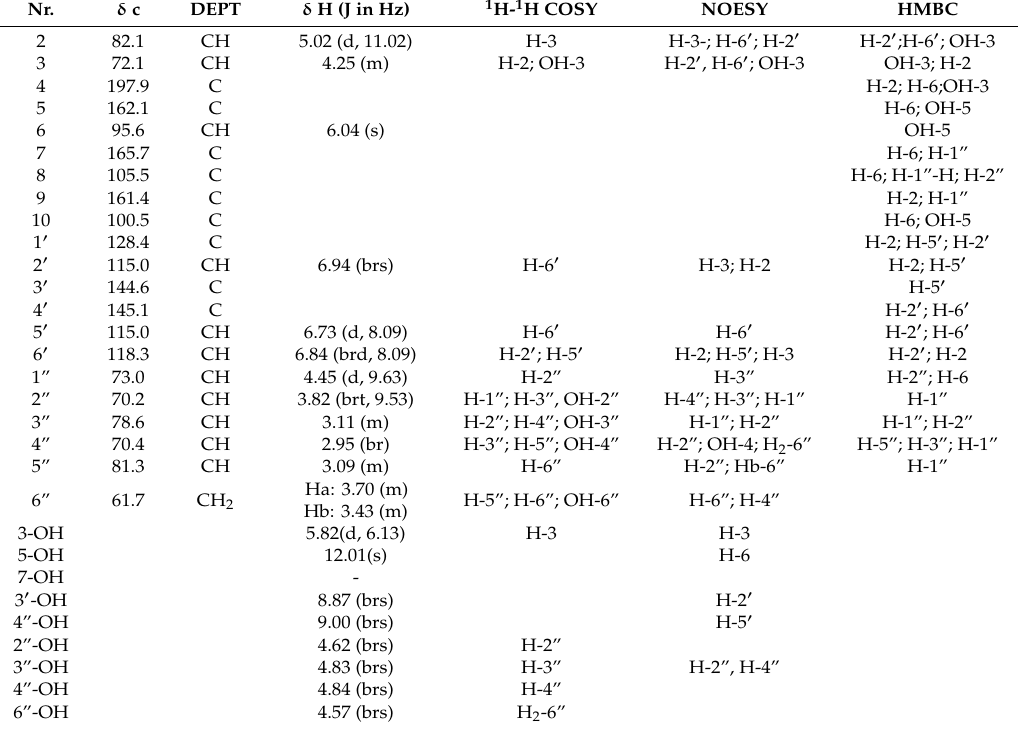
Table 2. 1D and 2D 1 H/ 13 C NMR data of Fideloside ( 3 ) in DMSO-d6 as solvent.